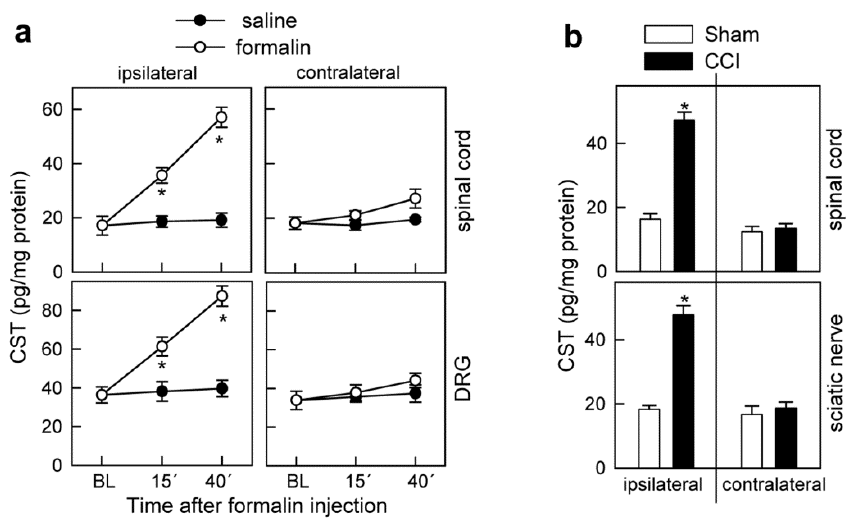
Figure 6. Production of cortistatin by the nociceptive system during inflammatory and neuropathic pain. ( a ) Cortistatin levels in lumbar dorsal root ganglia (DRG) and dorsal spinal cord (ipsilateral and contralateral to the injected paw) isolated before (BL, baseline) or at different times after i.pl. injection of formalin. Mice i.pl. injected with saline were used as a reference. n = 5 mice/group. ( b ) Cortistatin levels in the sciatic nerve and spinal cord ipsilateral and contralateral to surgery, measured five days after CCI. Sham-operated mice were used as a reference. n = 6 mice/group. * p < 0.0001 versus saline-treated mice (in a) or sham-operated mice (in b). All data represent mean ± SEM.